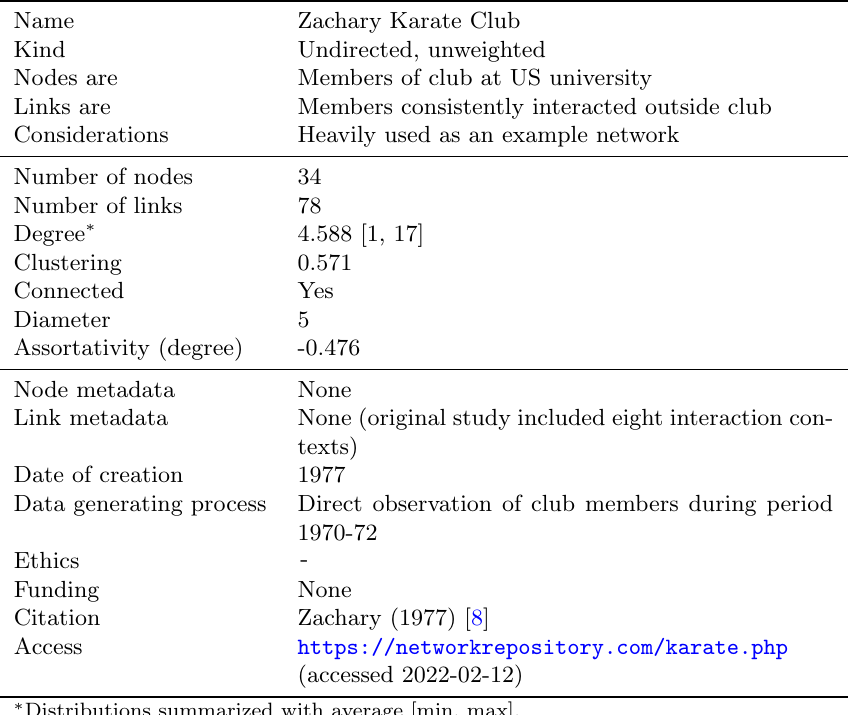
Table 1 Example network card for the Zachary Karate Club Name Zachary Karate